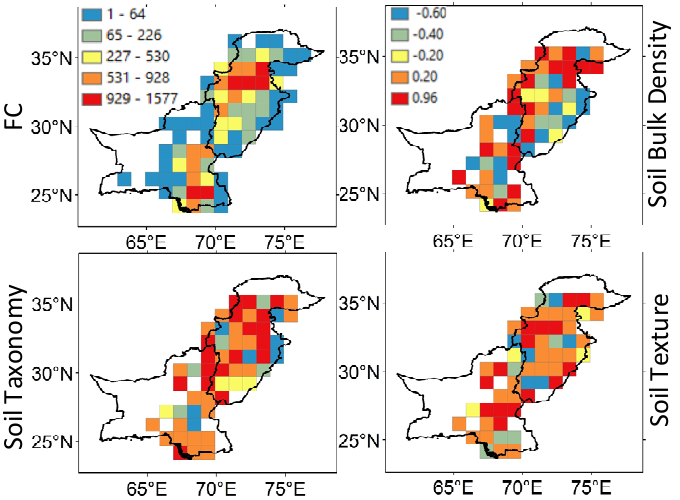
Figure 6. During the period 2001–2020, the spatial distribution of the number of monthly paired observations (1.0° grids) of wildfires and soil parameters.